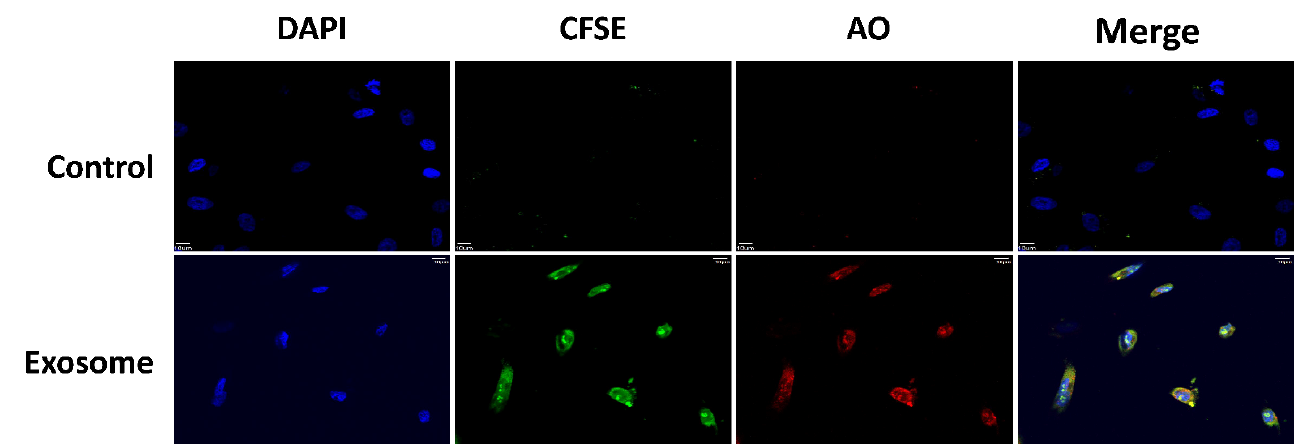
Figure 2. Confocal imaging of the uptake of labeled, purified ADSC-exo (30 µg) by HUVECs (Exosome) against those cells treated with medium (Control). The green fluorescence of CFSE and red fluorescence of AO found inside the cells indicated the uptake of protein and RNAs, respectively, by the ADSC-exo into the HUVECs. DAPI: 4 (cid:48) ,6-diamidino-2-phenylindole; CFSE: carboxyfluorescein succinimidyl diacetate ester; AO: acridine orange.